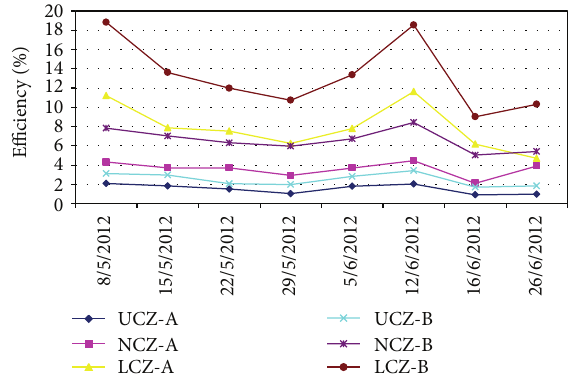
Figure 3: Efficiency curves of solar ponds “A” and